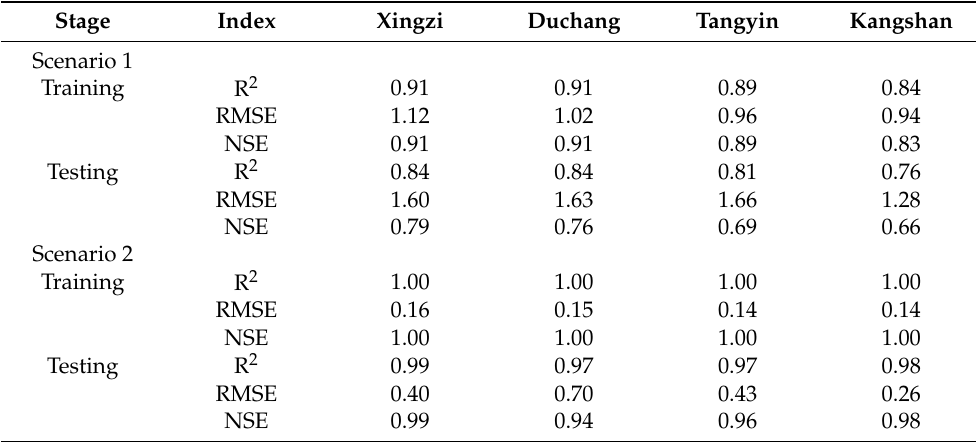
Table 2. Performance evaluation using the Transformer model for water level